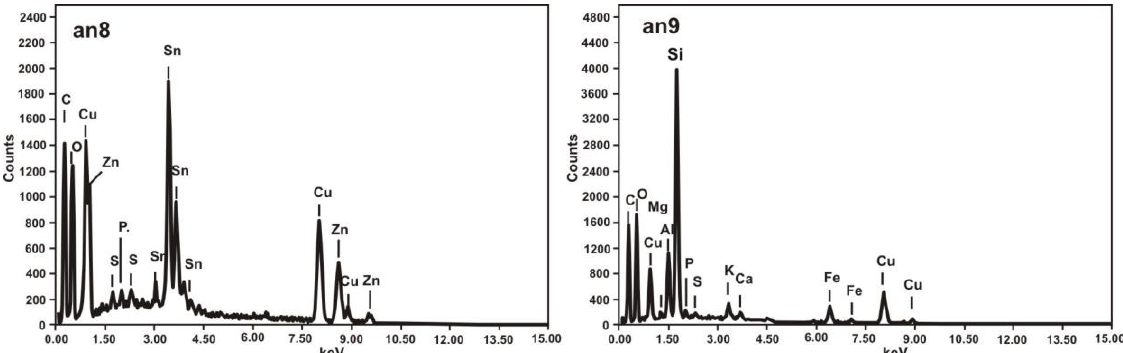
Figure 27. EDS spectrograms of the fibula micro-sample elementary composition at the points indicated in Figure 26(b).